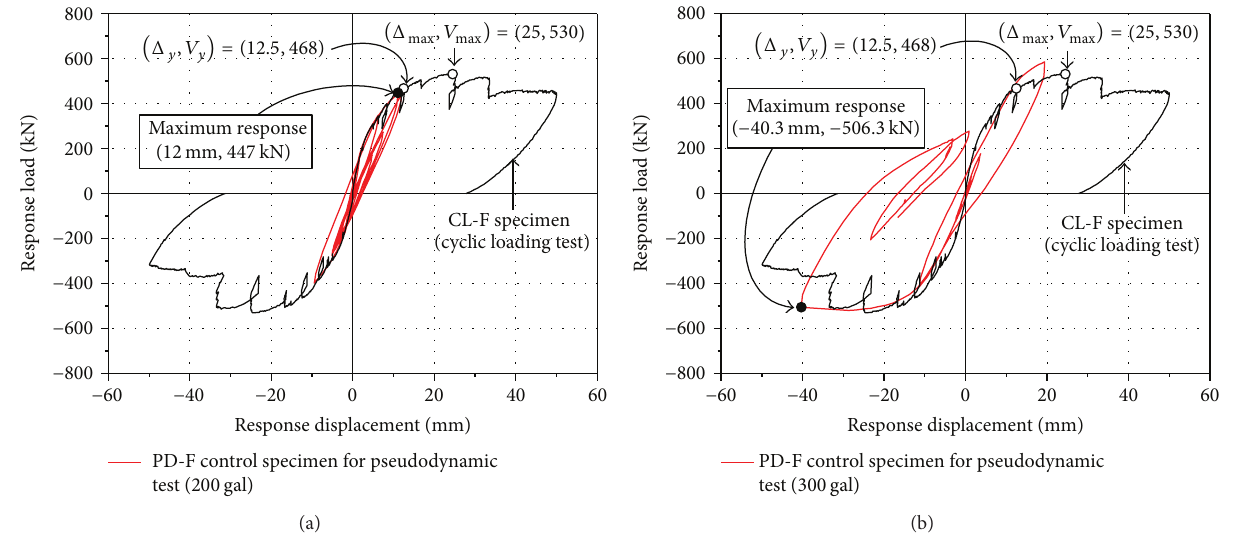
Figure 15: Lateral response load-displacement relationships of the PD-F control specimen during pseudodynamic test: (a) 200 gal and (b) 300 gal.